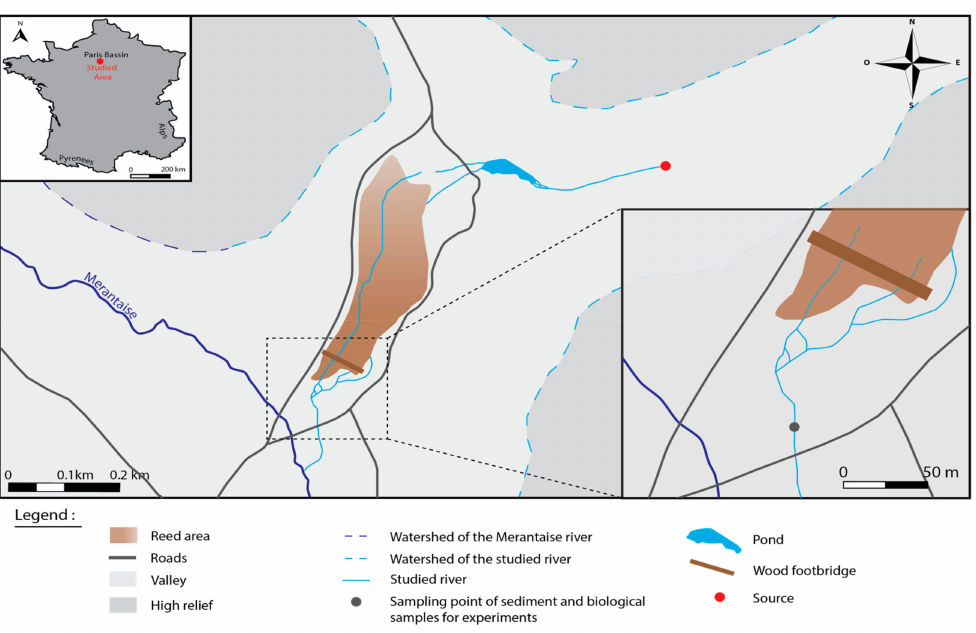
Figure 2. Location of the study site.